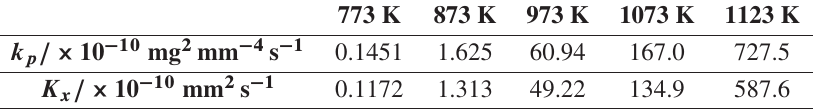
Table 1. Oxidation rate constants of Cu-38at.%Zn alloy.